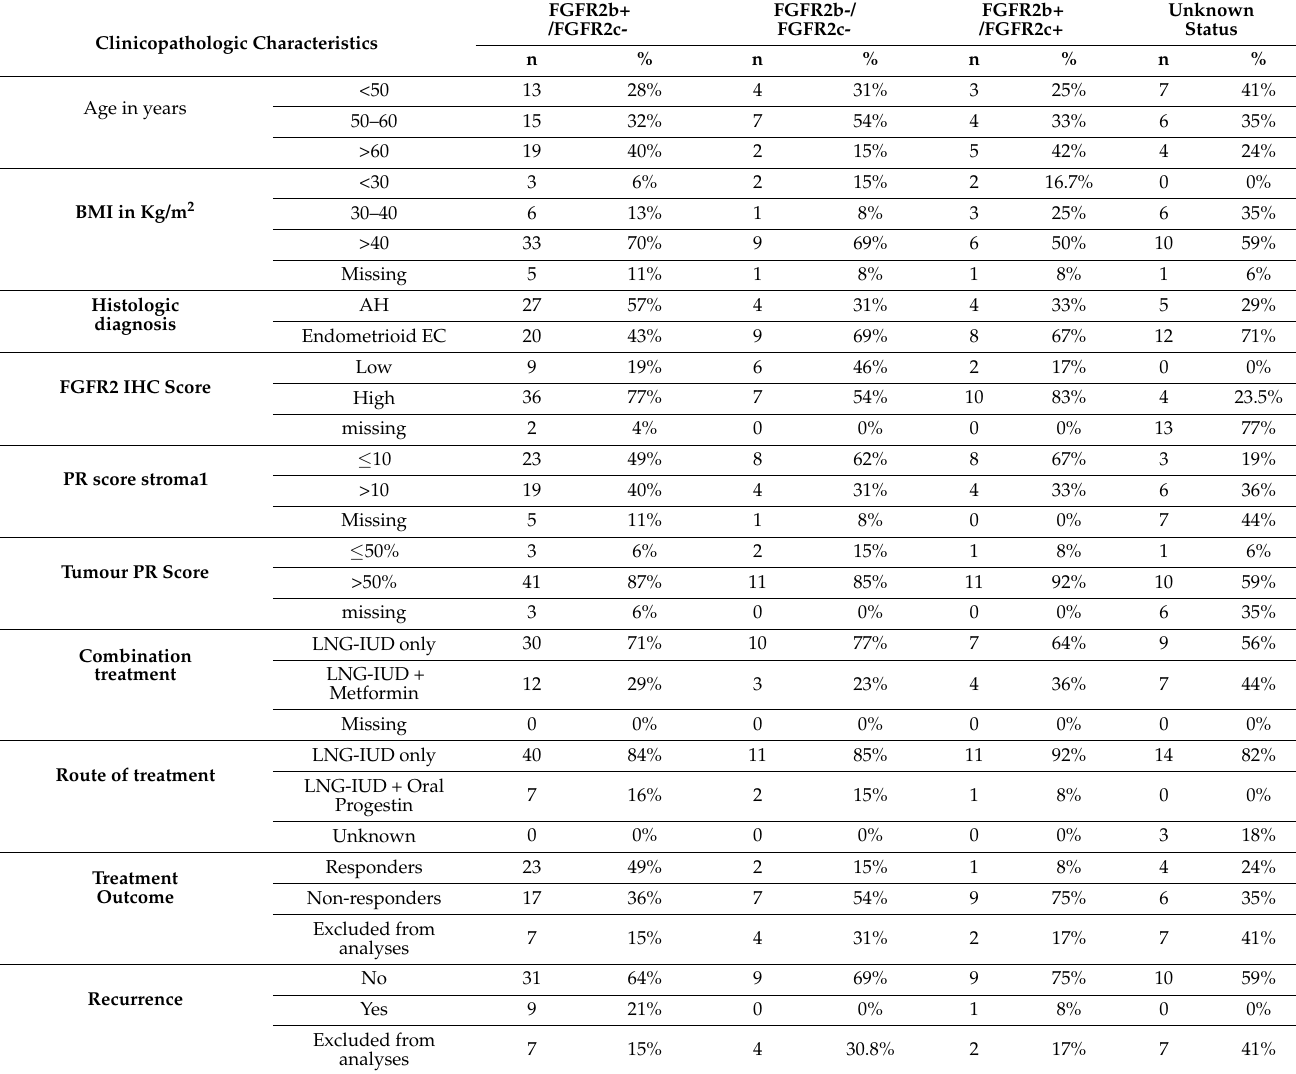
Table 3. Association of clinicopathologic parameters and outcome with FGFR2 isoform status in 89 women.